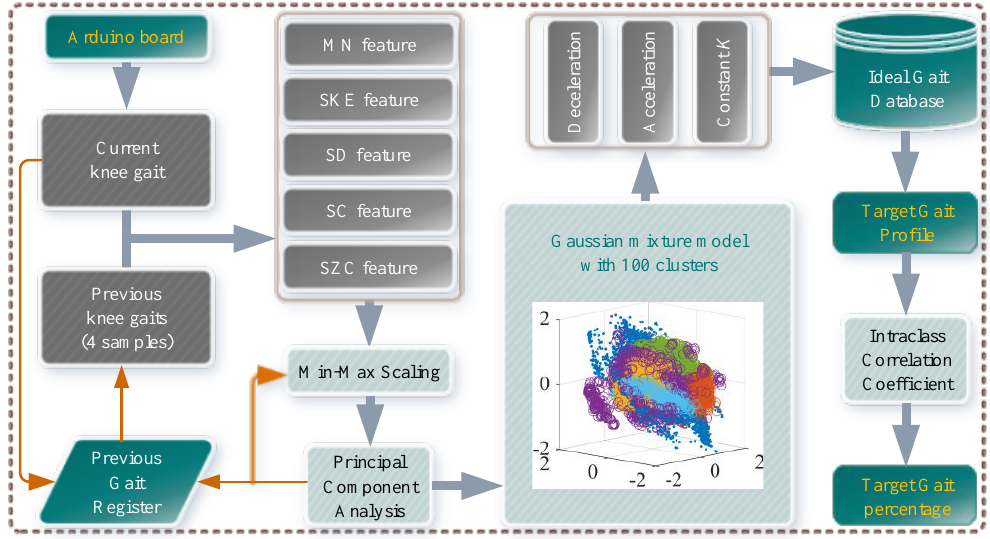
Figure 9. Gaussian mixture model-based gait classifier.